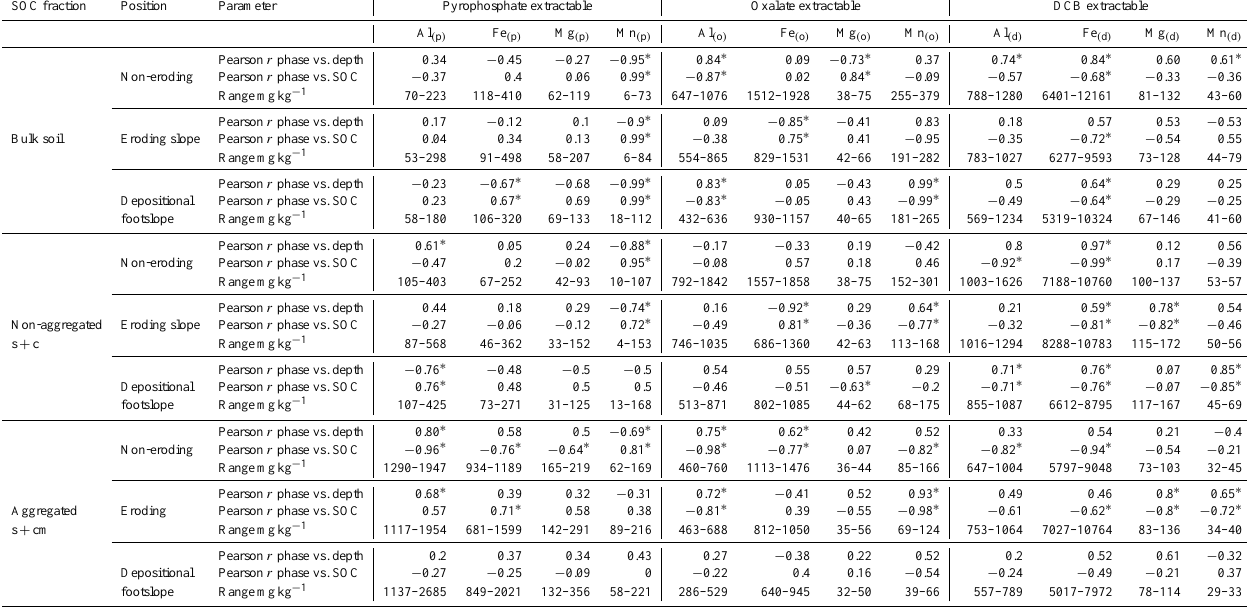
Table 3. Correlations (Pearson r ) between pyrophosphate, oxalate and DCB extractable solid soil phases and SOC or soil depth ( ∗ = p <0.1). SOCfraction